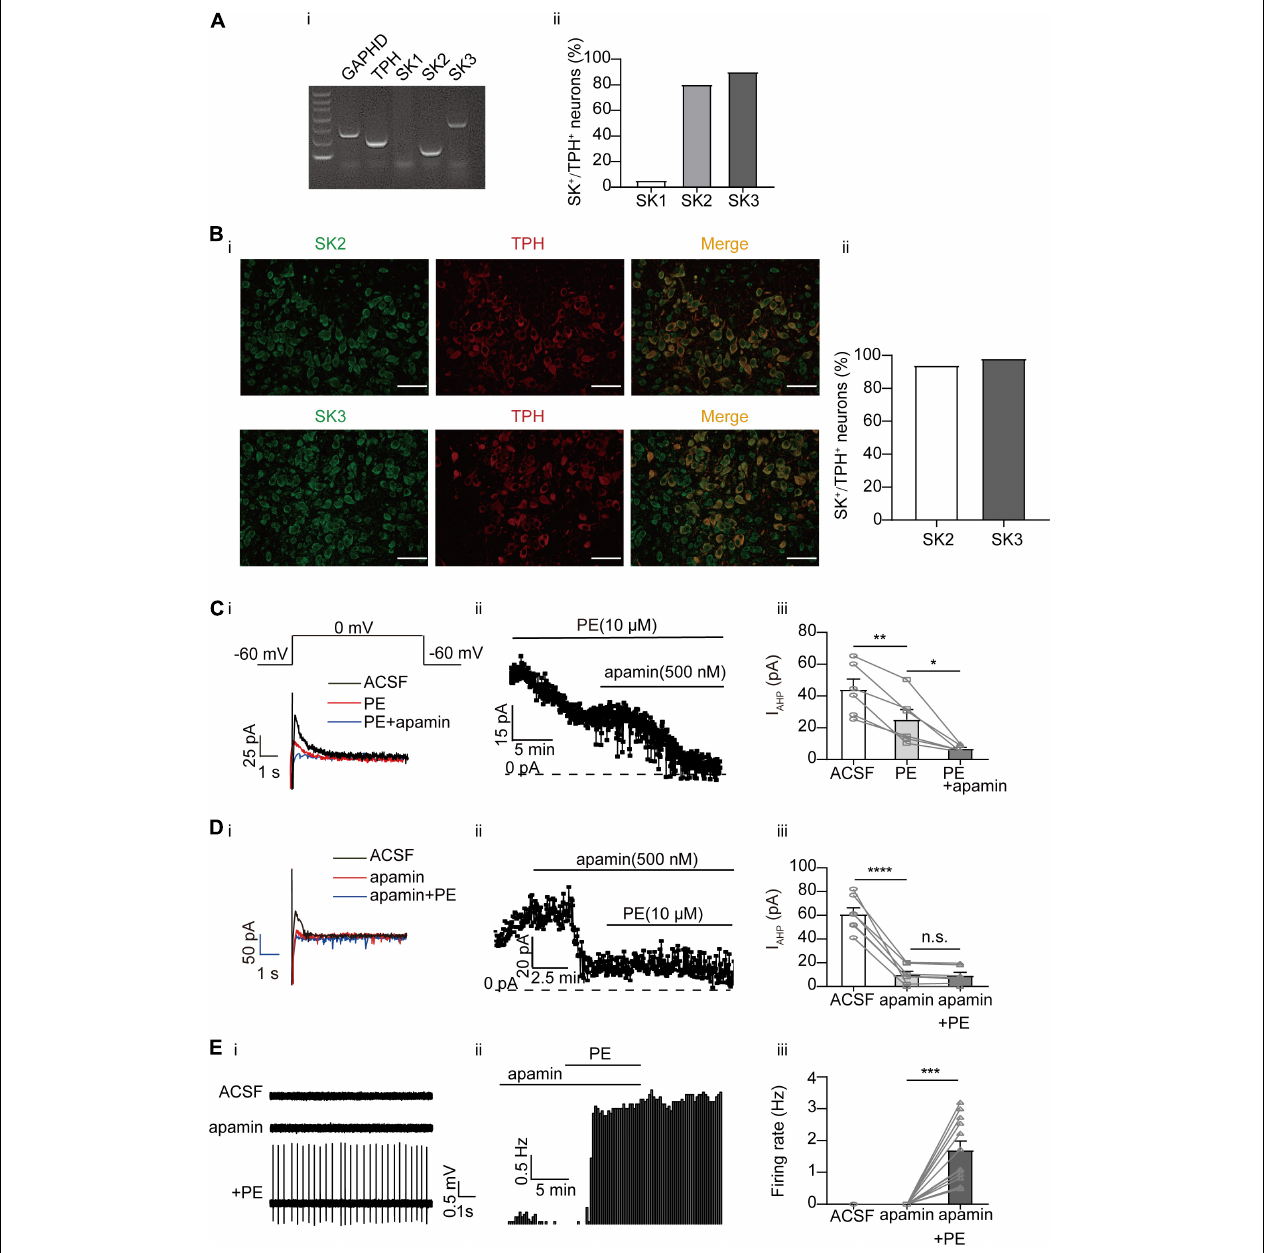
FIGURE 4 | Expression of SK channels and their contribution to the PE-induced spontaneous firing of the DRN 5-HT neurons. (A) Expression of SK channel-related subfamily members assessed using single-cell PCR analysis in the DRN neurons. (i) Representative image of single-cell PCR products showing the presence of different SK subunits. (ii) Proportion of SK1–SK3-positive neurons in the TPH-positive neurons ( n = 20). (B) (i) Confocal images of SK2 and SK3 expression in slice of the DRN, assessed using immunofluorescence methods. Scale bar = 50 µ m. (ii) Proportion of SK2 and SK3 positive neurons in the TPH-positive neurons ( n = 200). (C) PE potently inhibited I AHP currents, which was further inhibited by SK channel blocker apamin, recorded using whole-cell patch clamp in the DRN 5-HT neurons. (i) Recording protocol used and the typical current traces recorded; the latter were from 0 mV. The current amplitude at the beginning of the 0 mV step was measured; the effects of PE (10 µ M) and apamin (500 nM) are shown. (ii) Time course for current amplitudes measured in (i) . (iii) Summarized data for experiments shown in (i,ii) (paired t -test, ** p < 0.01, * p < 0.05, n = 6). (D) PE did not further inhibit I AHP current in DRN 5-HT neurons, following the application of apamin (500 nM). (i) Recording protocol used and the typical current traces recorded. (ii) Time course for current amplitudes measured in (i) . (iii) Summarized data for experiments shown in (i,ii) (paired t -test, **** p < 0.0001, n . s . p > 0.05, n = 7). (E) SK channel blocker apamin (500 nM) did not induce spontaneous firing of the DRN 5-HT neurons. (i) Representative traces of action potential spikes recorded using “loose patch” under current-clamp configuration. (ii) Example time course of the spontaneous firing frequency in a 5-HT neuron, under the influence of apamin and PE. (iii) Summarized data for the effects of apamin and PE on the spontaneous firing frequency (Wilcoxon matched-pairs signed-rank test, *** p < 0.001, n = 12).